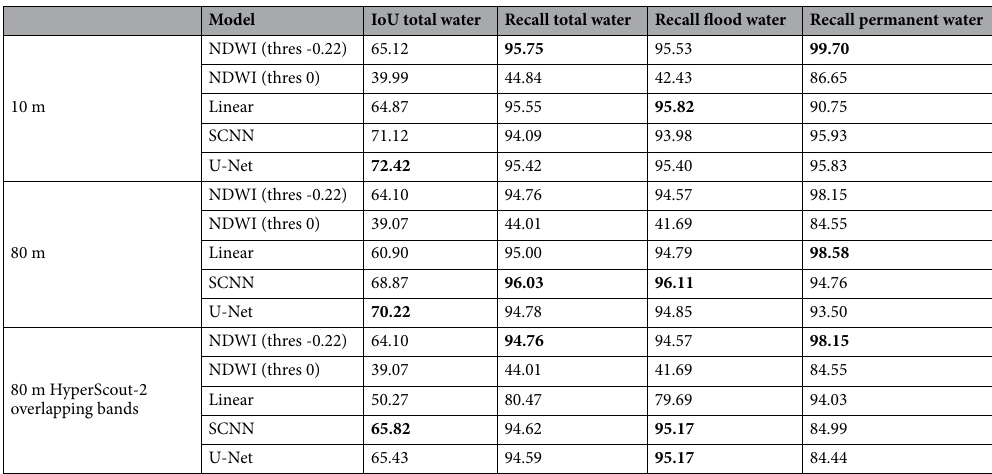
Table 2. IoU and recall results for models trained on WorldFloods . Bold values indicate highest metric value for each resolution and band combination.